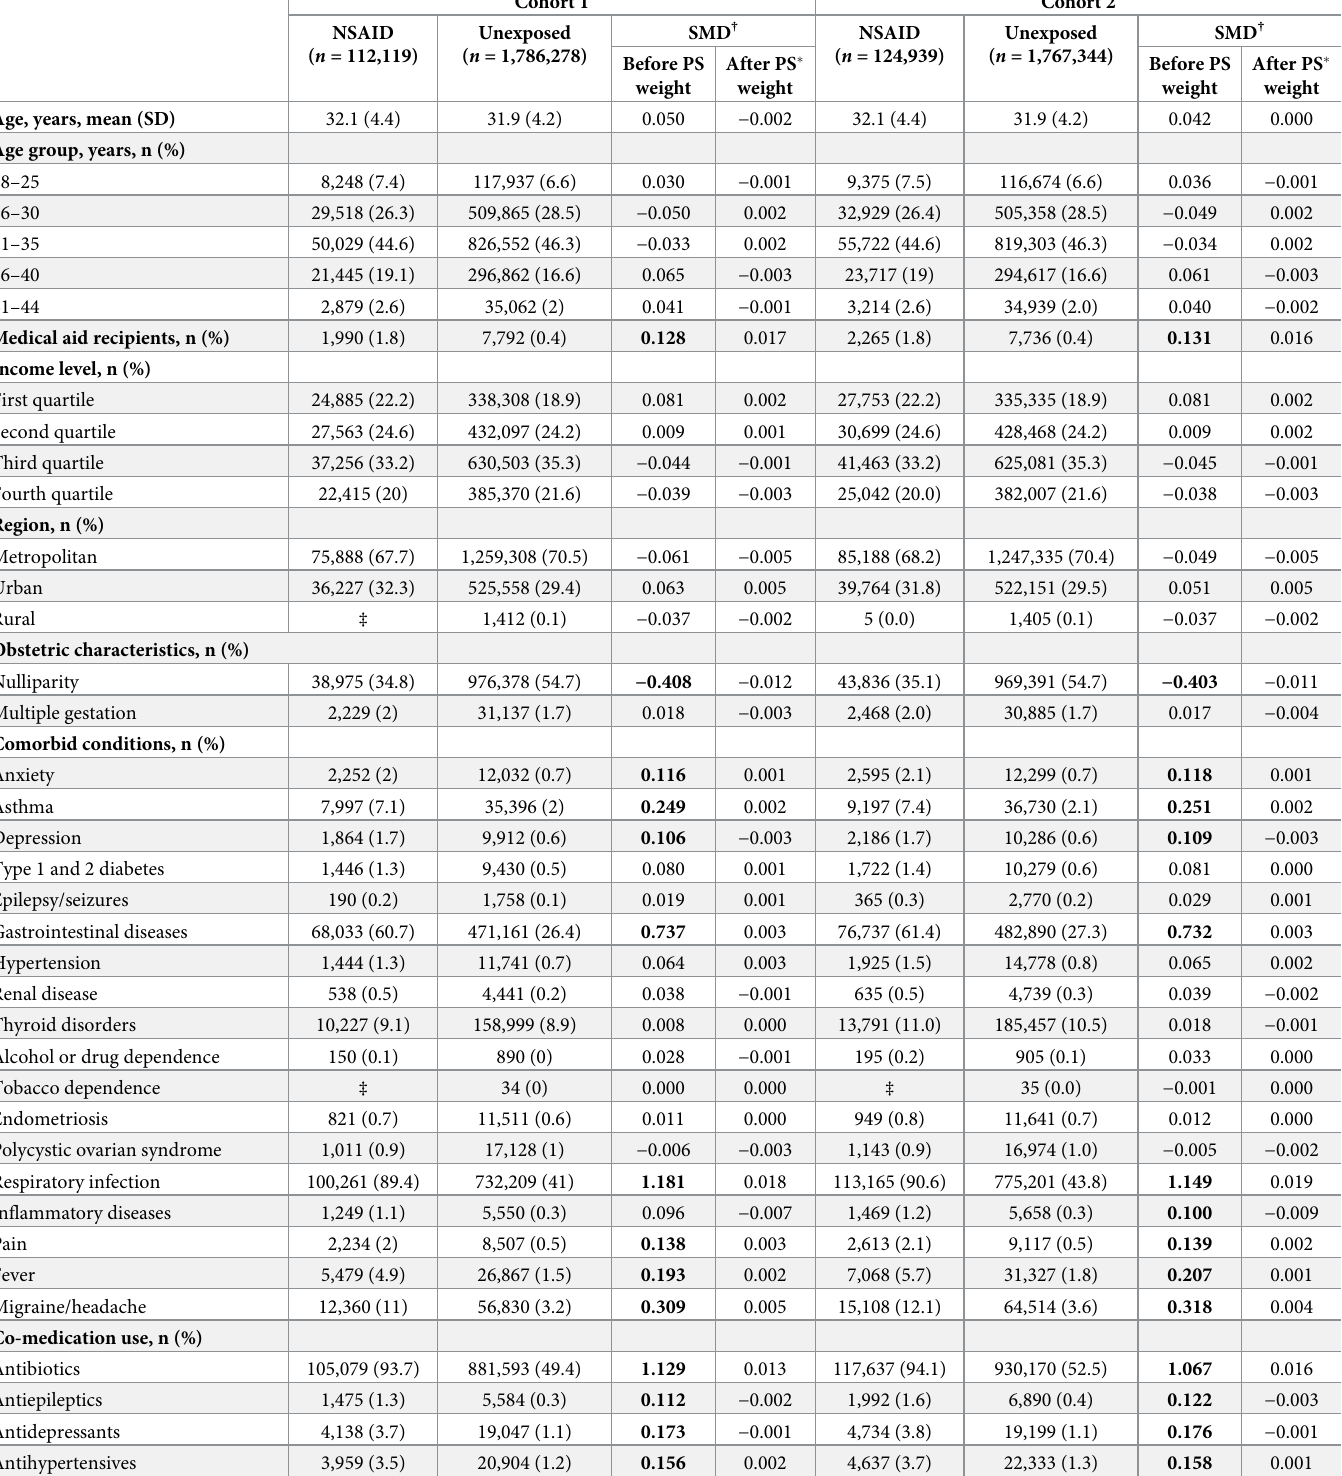
Table 1. Baseline characteristics of pregnancies exposed to NSAID during the first trimester (cohort 1) or early pregnancy (cohort 2) before and after PS fine strati- fication